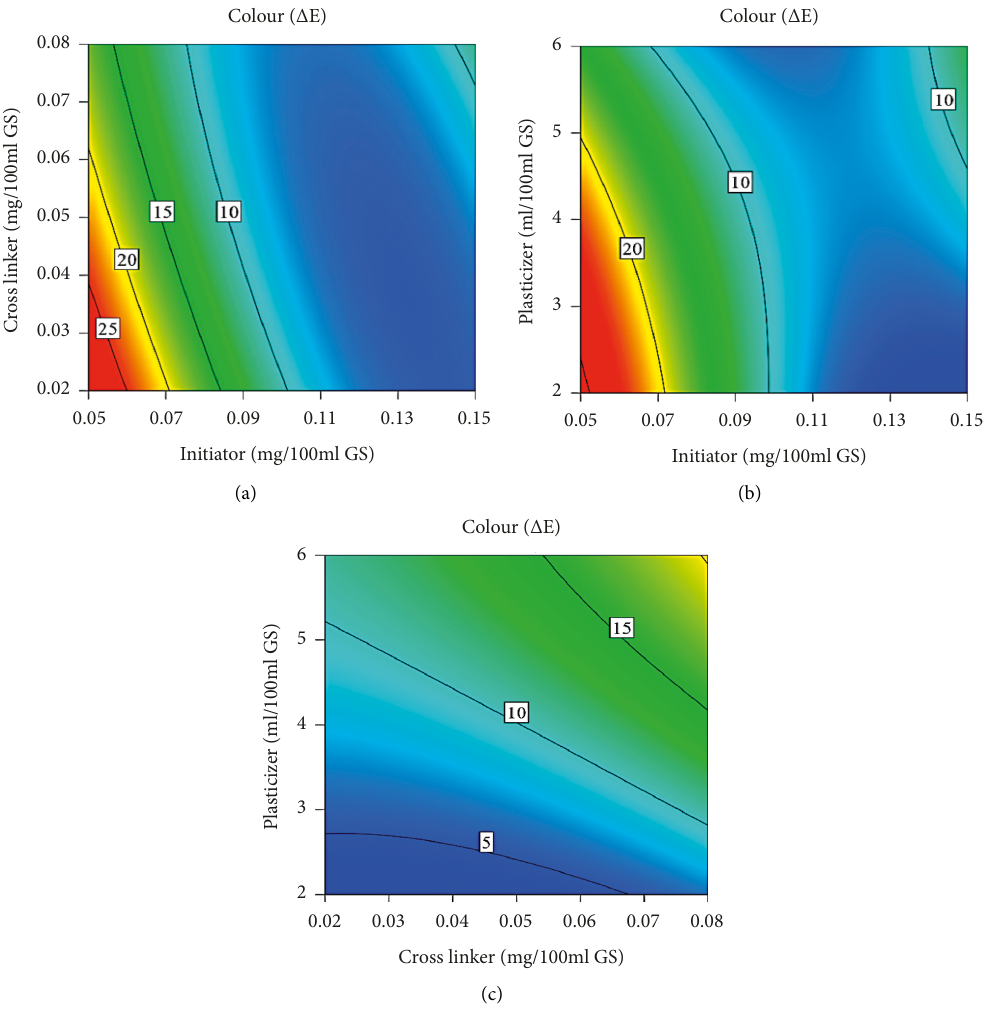
Figure 2: (a) Combined effects of initiator and crosslinker on color difference at the optimum value of plasticizer concentration (2.88 mL/ 100 mL GS). (b) Combined effects of initiator and plasticizer concentration on color difference at the optimum value of crosslinker (0.02 mg/100 mL GS). (c) Combined effects of crosslinker and plasticizer concentration on color difference at the optimum value of initiator (0.15 mg/100 mL